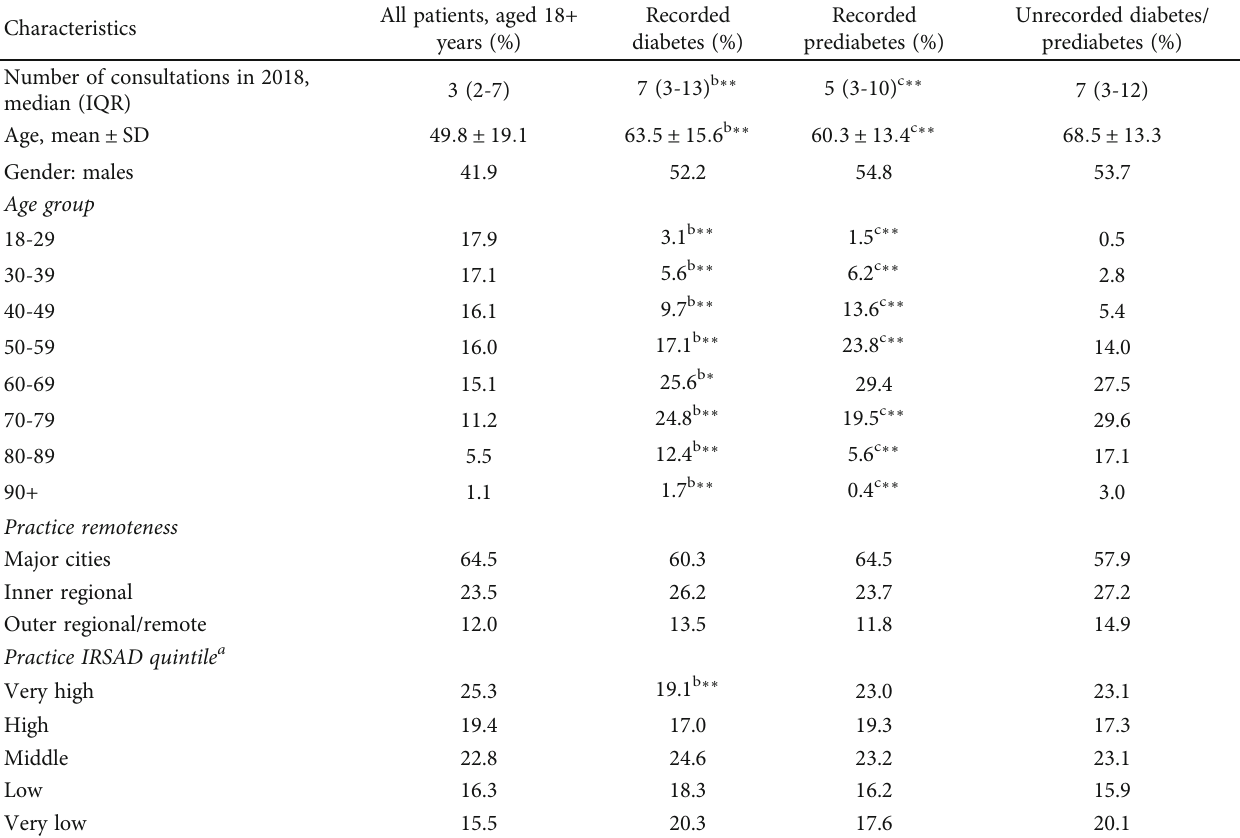
Table 1: Sociodemographic pro fi le of the study population (regular patients aged 18+ years) according to diabetes diagnosis status (2016-